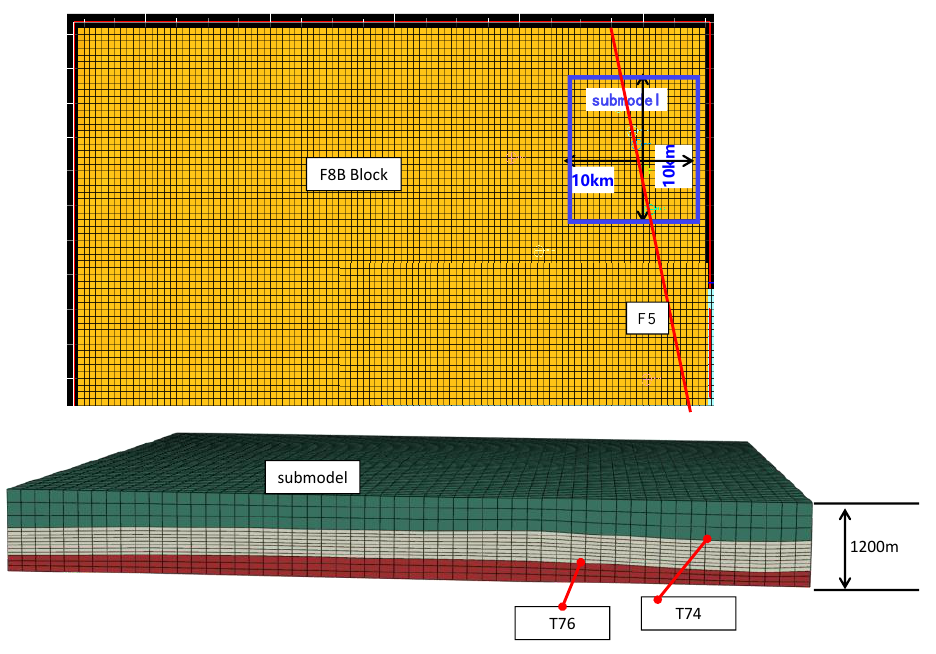
Figure 8. Illustration of relative location of the submodel and its finite element mesh.